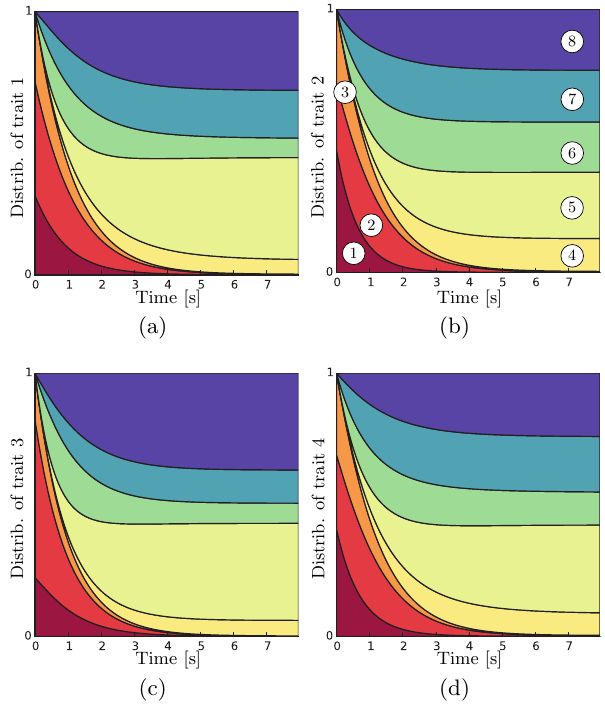
Figure 2: Evolution over time of the trait distribu- tion as specified by the distributions shown in Fig. 1. Each subplot represents one trait, indicating the dis- tribution of that trait over the set of tasks (task 1 is shown at the bottom and task 8 at the top).